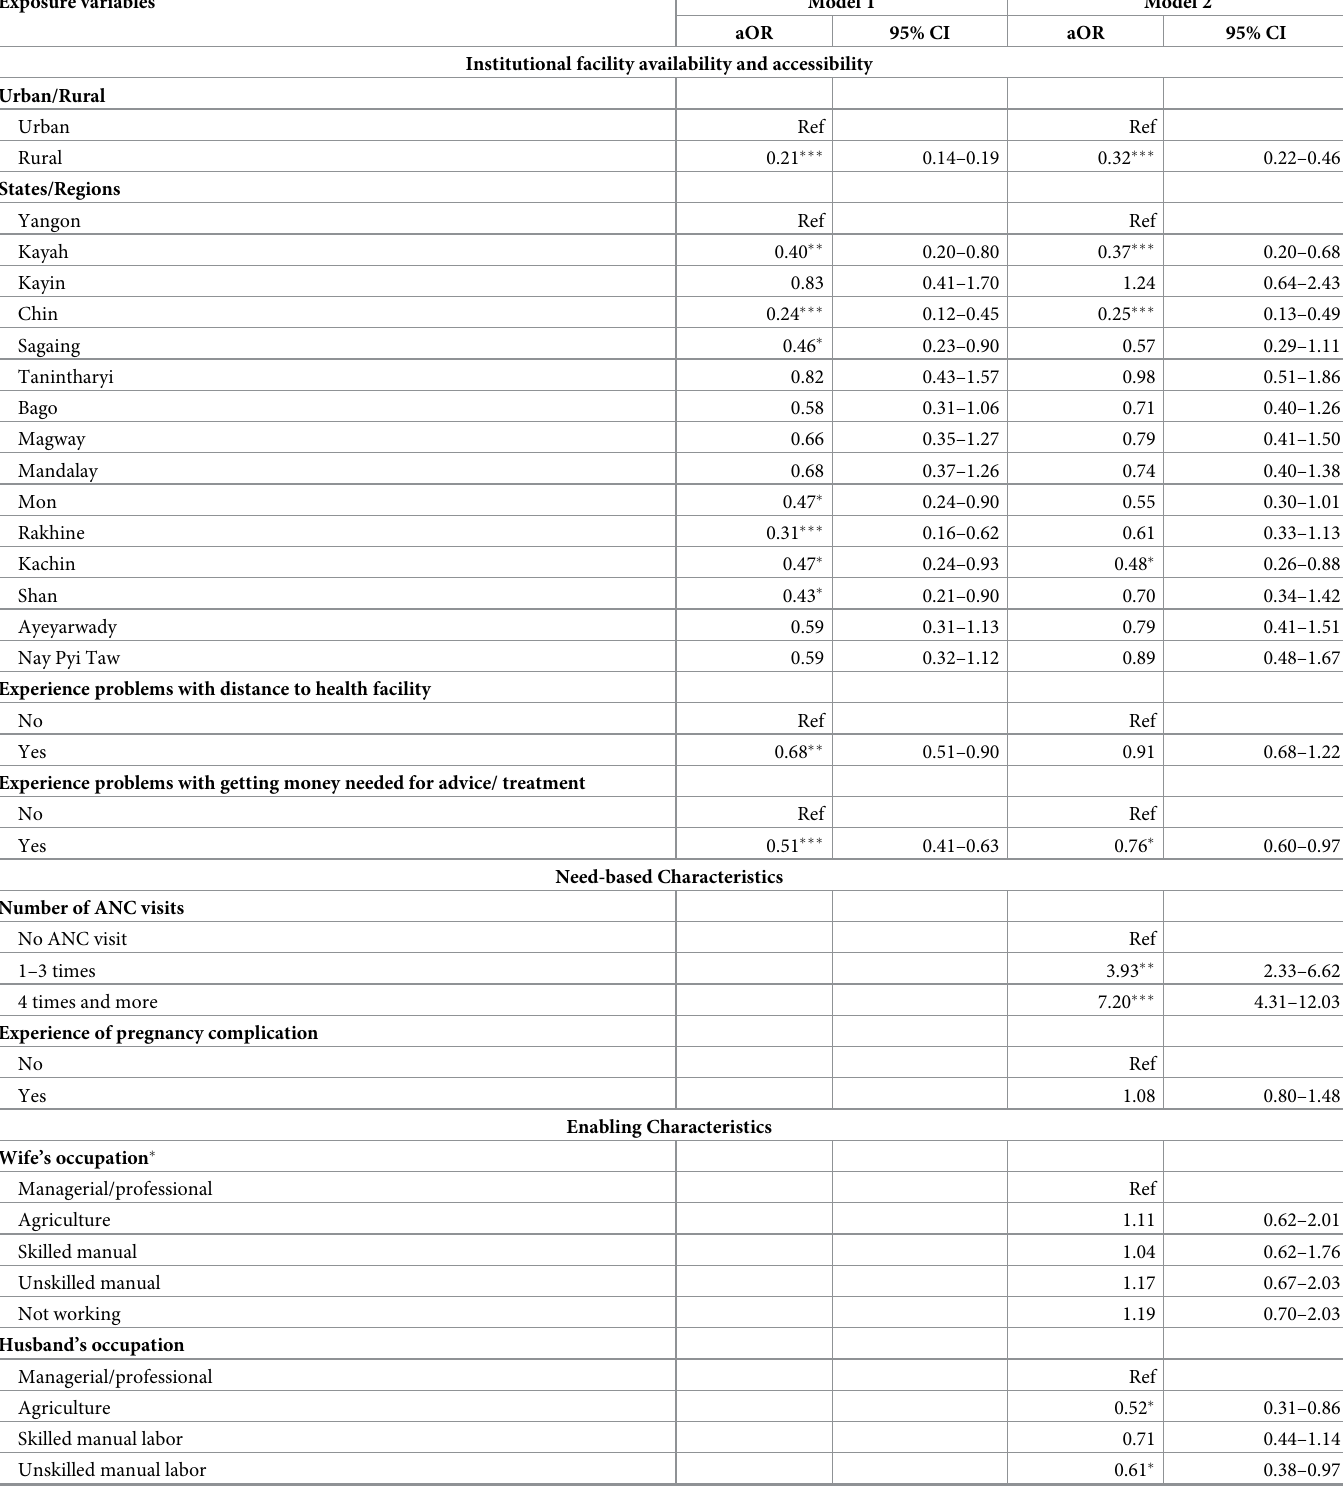
Table 1. Adjusted Odds Ratios (aOR): Factors associated with institutional delivery (N = 3268)